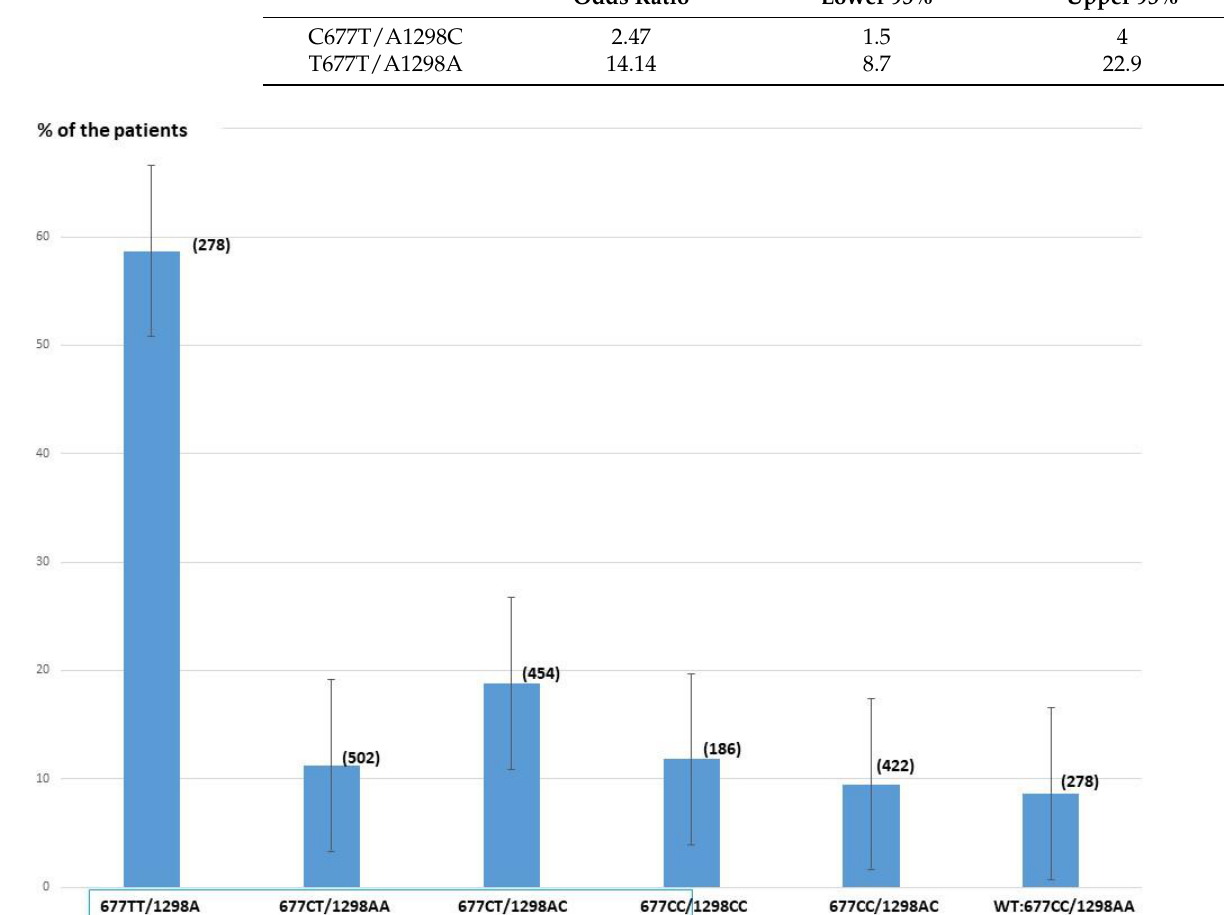
Figure 3. Percentage of patients with a serum Hcy level >15 micromolar for each MTHFR SNP combination. (number of patients).